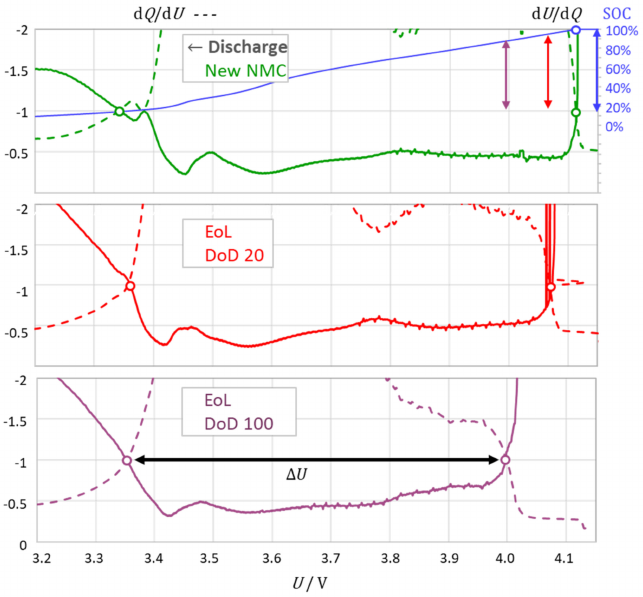
Figure 3. NMC batteries of the same type (LG ICR18650HE): Intersection method for brand new condition and end-of-life after flat and deep cycling test at constant current (900 cycles, 0.3 A = C/10). The usable voltage range = distance between the intersections ( ◦ ) becomes smaller with forced